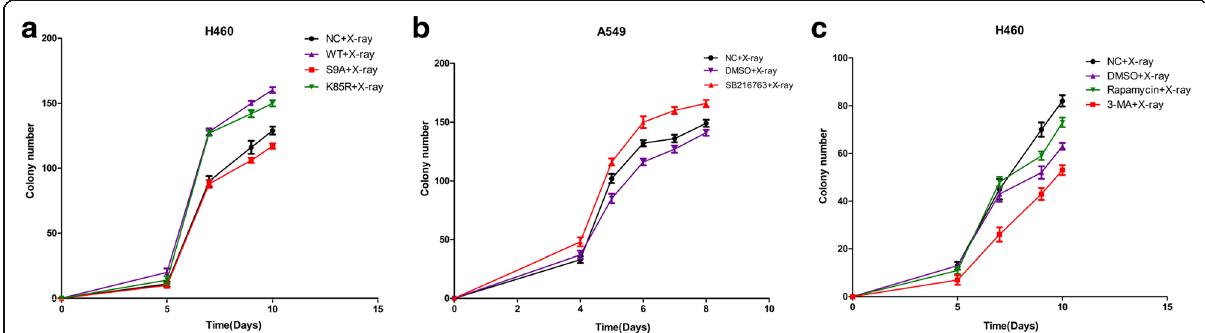
Fig. 6 Clonogenic ability of cells after treatment and X-ray irradiation. Colony formation in H460 cells transfected with GSK-3 β with different activity levels [wild type GSK-3 β (GSK-3 β -WT), constitutively active GSK-3 β -S9A, and catalytically inactive GSK-3 β -K85R)] and X-ray irradiation ( a ). After transfection with GSK-3 β with different activity levels, the clone-forming ability of activated GSK-3 β -S9A was reduced, and cell viability was decreased. Colony formation in A549 cells after GSK-3 β inhibition (SB216763) and X-ray irradiation ( b ). After inhibiting GSK-3 β activity, the clone-forming ability and cell viability increased. Colony formation in H460 cells after inhibiting or promoting autophagy (cells were treated with the autophagy inducer rapamycin and the autophagy inhibitor 3-MA) and X-ray irradiation ( c ). After inhibiting autophagy with 3-MA, the reduction in clone-forming ability was more significant, and cell viability was